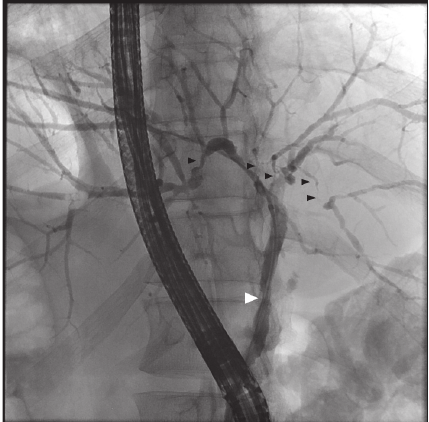
Figure 1: ERC of a patient with IgG4-associated autoimmune cholangitis showing intra- (black arrows) and extrahepatic strictures (white arrow) of the biliary tract (mixed type).